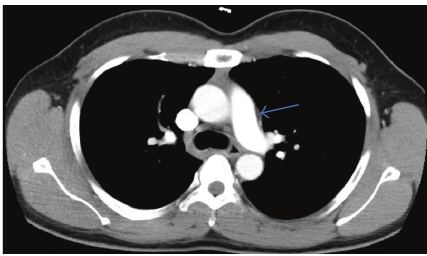
Figure 3: Axial CT scan of the chest (mediastinal window) with regression of mediastinal mass after several months of anti-TB therapy.